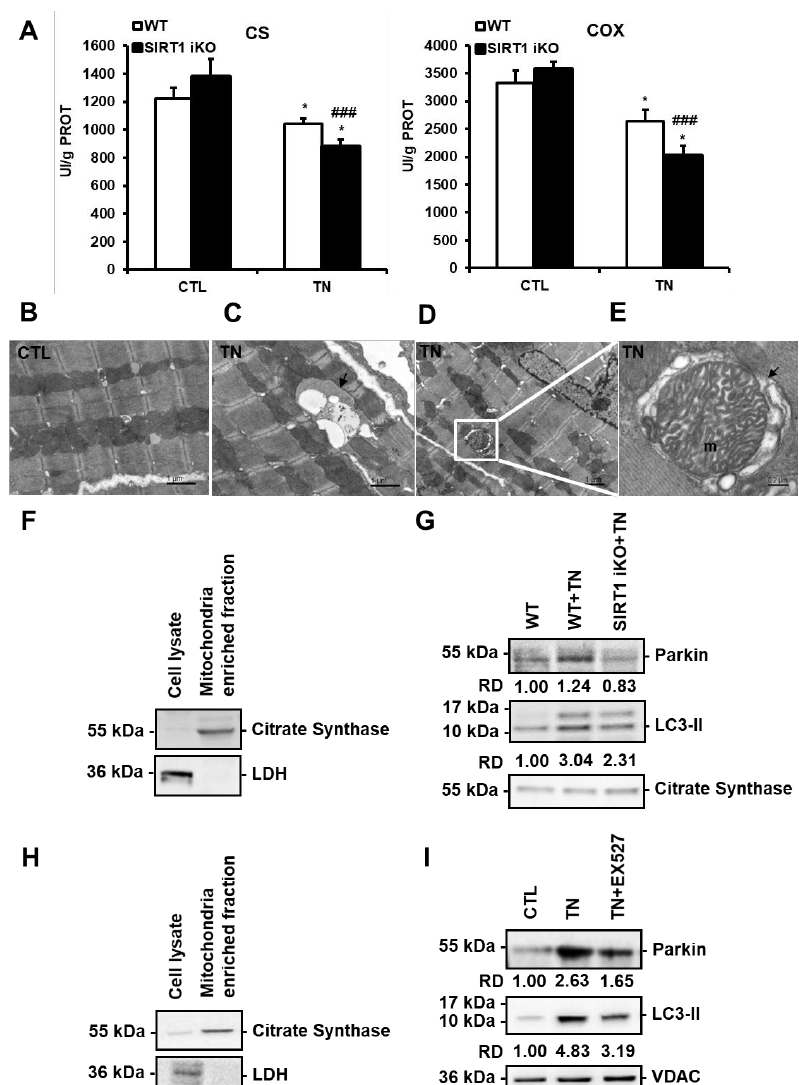
Figure 5. SIRT1 activates mitophagy in response to ER stress. ( A ) The activity of citrate synthase (CS) and cytochrome c oxidase (COX) in wild-type (WT) or SIRT1 iKO cardiac homogenates after vehicle or tunicamycin (TN) treatment. Enzymatic activities measured in UI/g proteins are presented in bar graphs as mean ± S.E.M. (n = 10). * P < 0.05 versus the respective control. ### P < 0.005 versus WT TN. ( B – E ) Electron micrographs of control ( B ) and tunicamycin (TN)-treated ( C – E ) cardiomyocytes showing autophagic/mitophagic vacuoles are presented. Figure 5C shows an autophagic vacuole (black arrow) surrounded by mitochondria. Figure 5D shows an autophagic vacuole containing a mitochondrion (white square). An enlarged micrograph of this vacuole is presented in Figure 5E. A swollen mitochondrion (m) can be observed in the autophagic vacuole (black arrow). ( F , G ) Immunoblots of mitochondrial fractions isolated from WT and SIRT1 iKO heart homogenates 16 h after tunicamycin (TN) injection (n = 5). ( F ) Purity of the mitochondrial fraction. ( G ) Western blot analysis of Parkin and LC3-II amounts in the mitochondrial fraction isolated from WT and SIRT1 iKO mouse hearts after administration of vehicle or tunicamycin (TN). Citrate synthase (CS) was used as a loading control. RD: Relative density. ( H , I ) Immunoblots of mitochondrial fractions isolated from H9c2 cells 16 h after tunicamycin (TN) treatment (n = 3). ( H ) Purity of the mitochondrial fraction. ( I ) Western blot analysis of Parkin and LC3-II amounts in the mitochondrial fraction of H9c2 cells treated or not with 10 µ g / mL tunicamycin (TN) ± 50 µ M EX527 (Sirt1 inhibitor). VDAC (Voltage-dependent anion channel) was used as a loading control. RD: Relative